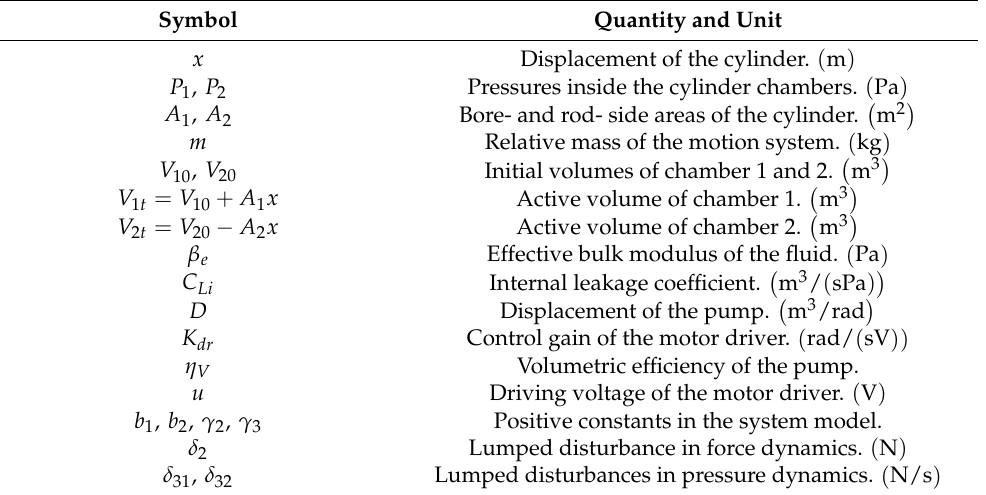
Parameters used for mathematical modeling the EHA system are defined in Table 3 below. Table 3. Major components in the considered EHA Table 3. Major components in the considered EHA system.